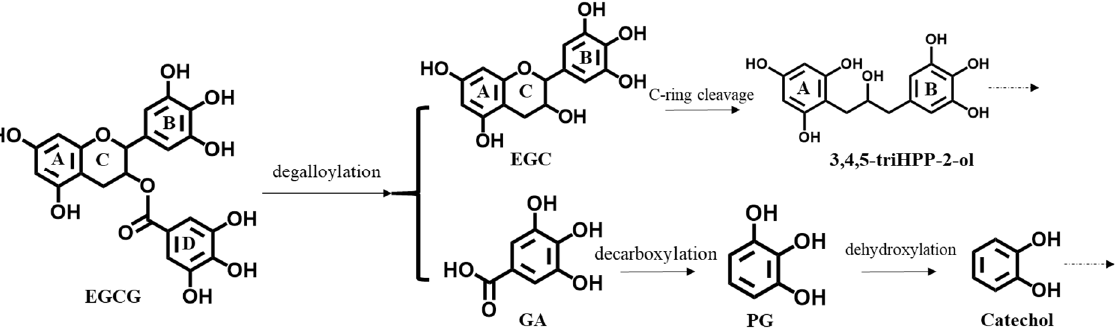
Figure 1. Pathways of human intestinal microbial metabolism of EGCG. EGCG, (-)-epigallocatechin gallate; EGC, (-)-epigallocatechin; GA, gallic acid; PG, pyrogallol; 3,4,5-triHPP-2-ol; 1-(3 ′ ,4 ′ ,5 ′ - trihydroxyphenyl)-3-(2 ″ ,4 ″ ,6 ″ -trihydroxyphenyl)-2-propanol. Dotted arrows represent further degradations.